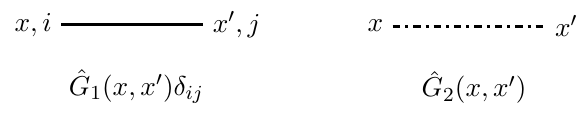
ˆ G 1 and 2 are used in the internal lines.